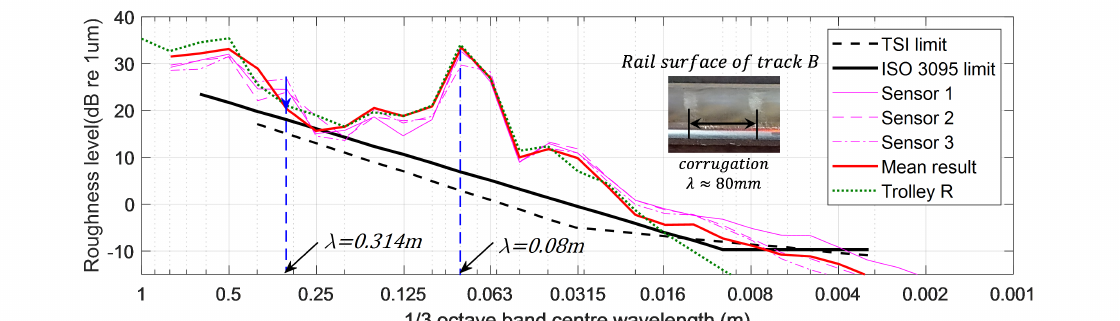
Figure 18. Spectral analysis of the Track B railhead